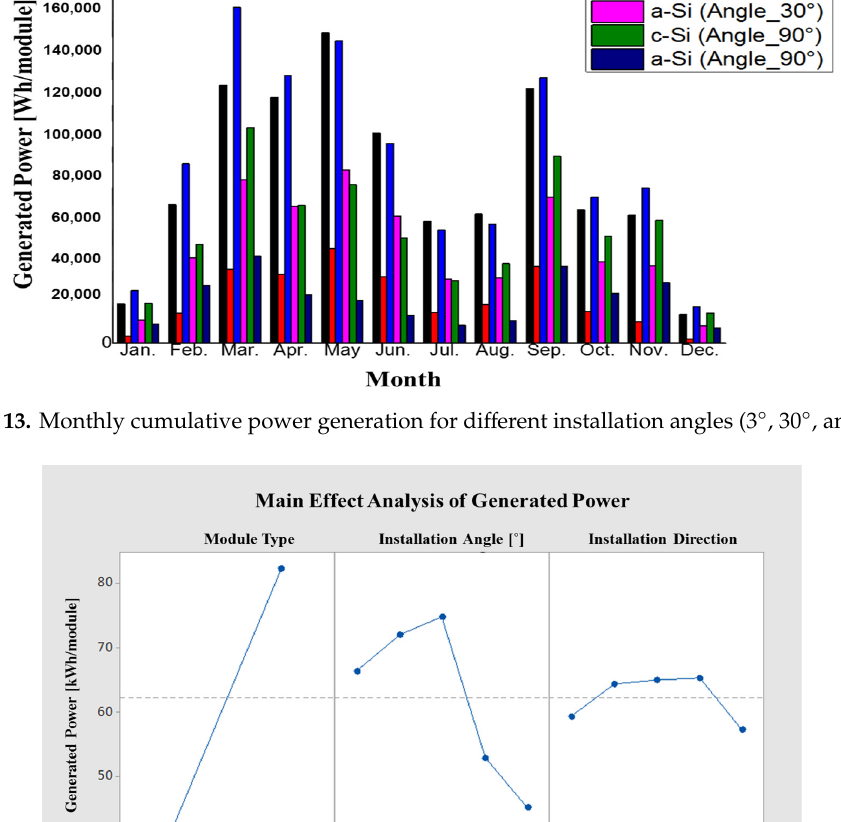
Figure 13. Monthly cumulative power generation for different installation angles (3°, 30°, and 90°).